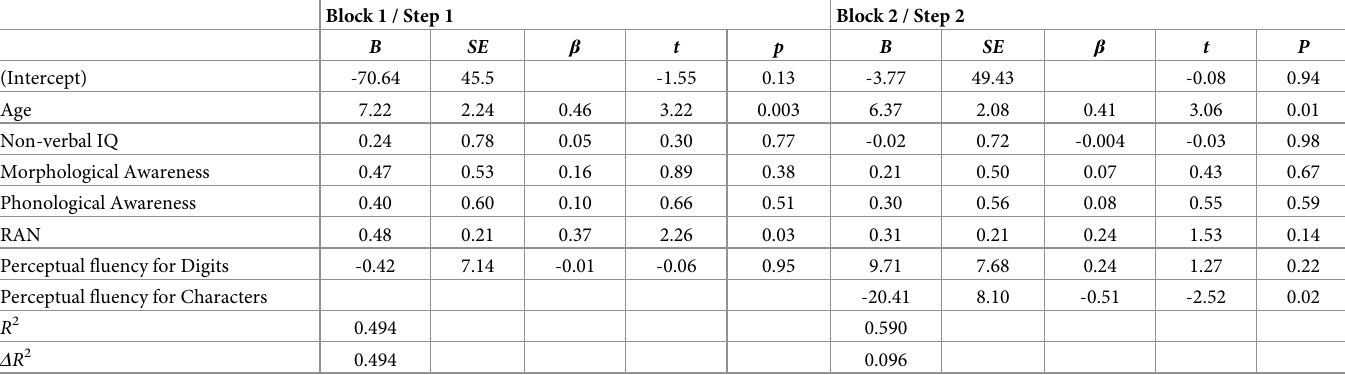
Table 4. Results of the hierarchical regression analysis for variables predicting non-speeded